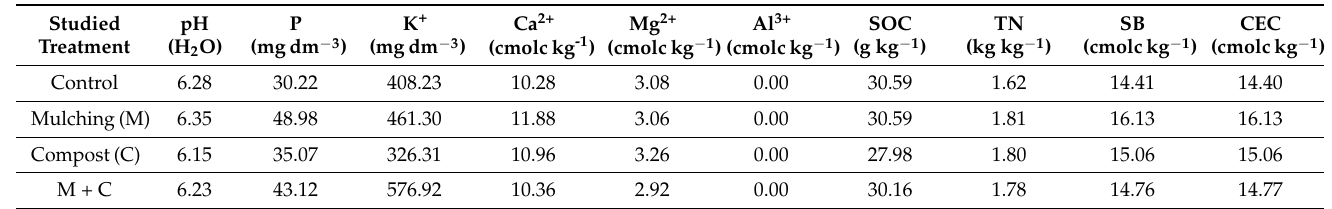
Table 1. Soil chemical properties of before to start the field experiment (mean, n = 192) in a 16-year